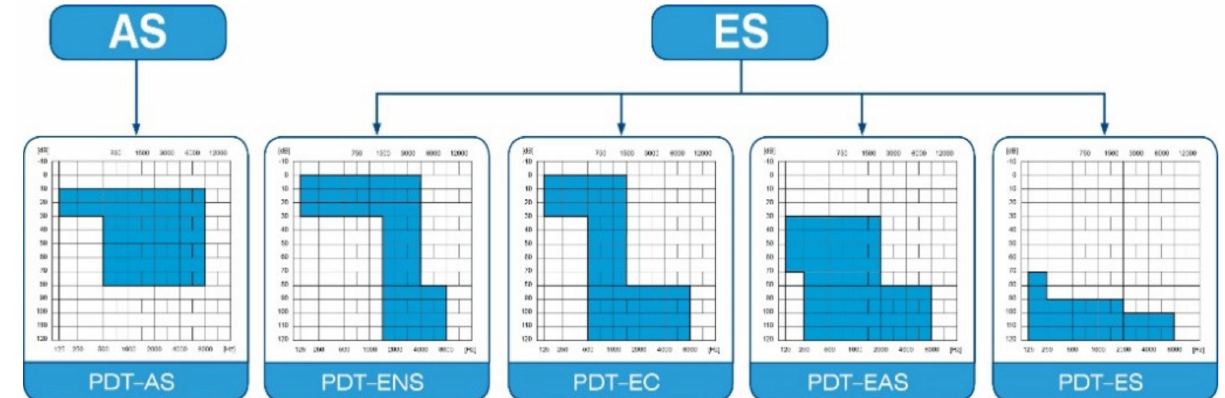
Figure 1. Partial deafness treatment groups for cochlear implantation. AS—acoustic stimulation; ENS—electro–natural stimulation; EC—electrical complement; EAS—electrical–acoustic stimulation; ES—electrical stimulation.